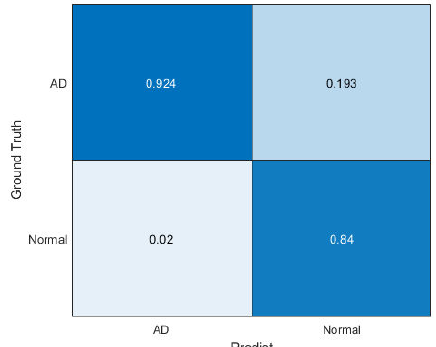
Figure 18. Confusion matrix of DeU-Net with fusion images.